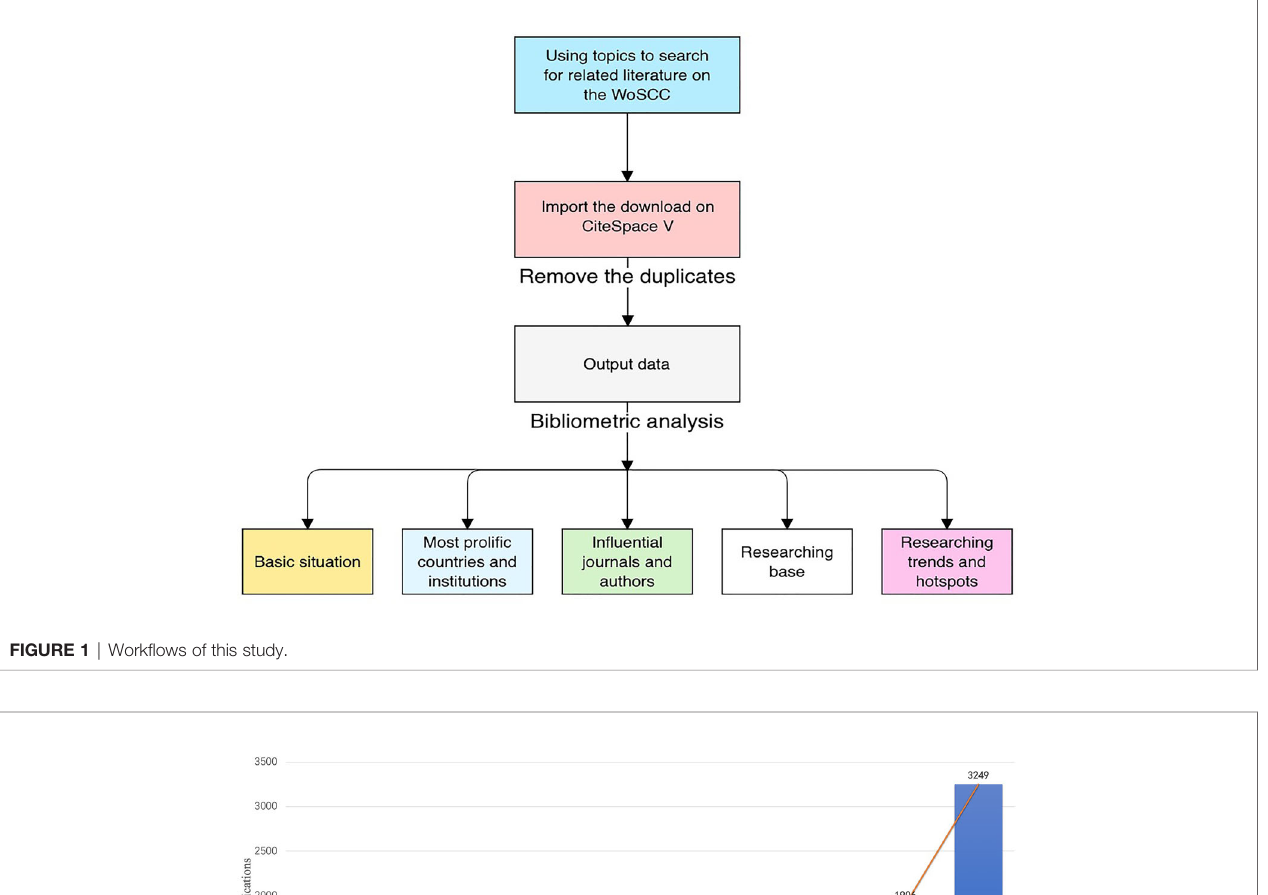
FIGURE 2 | Chronological distribution of publications in radiomics for oncology from 2011 to